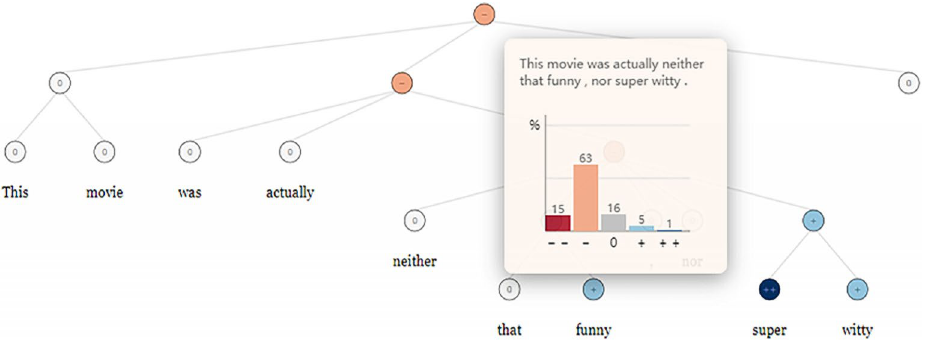
Figure 6. Example of the sentiment